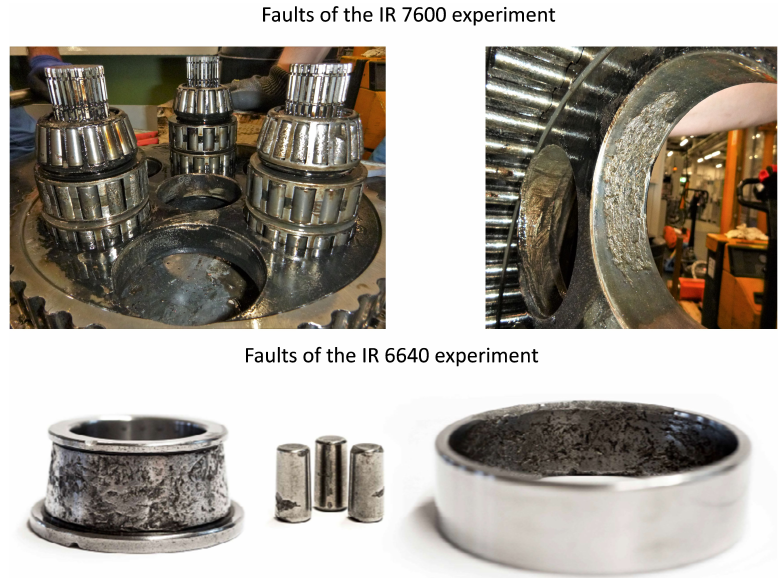
Figure 5. Overview of the faults of the accelerated wear tests following [3,39].